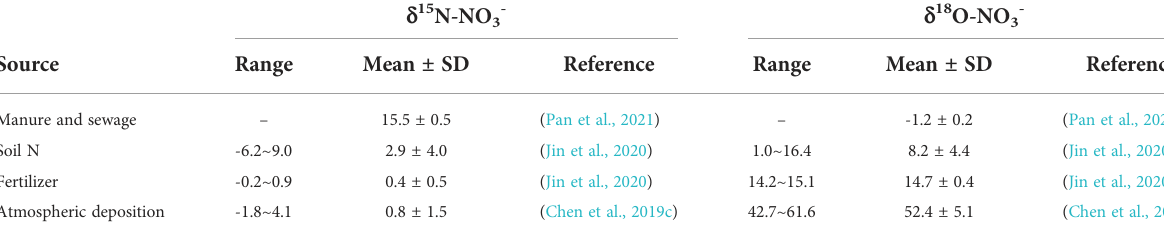
TABLE 2 The values ( ‰ ) of dual isotopes for the four potential nitrate sources at the river